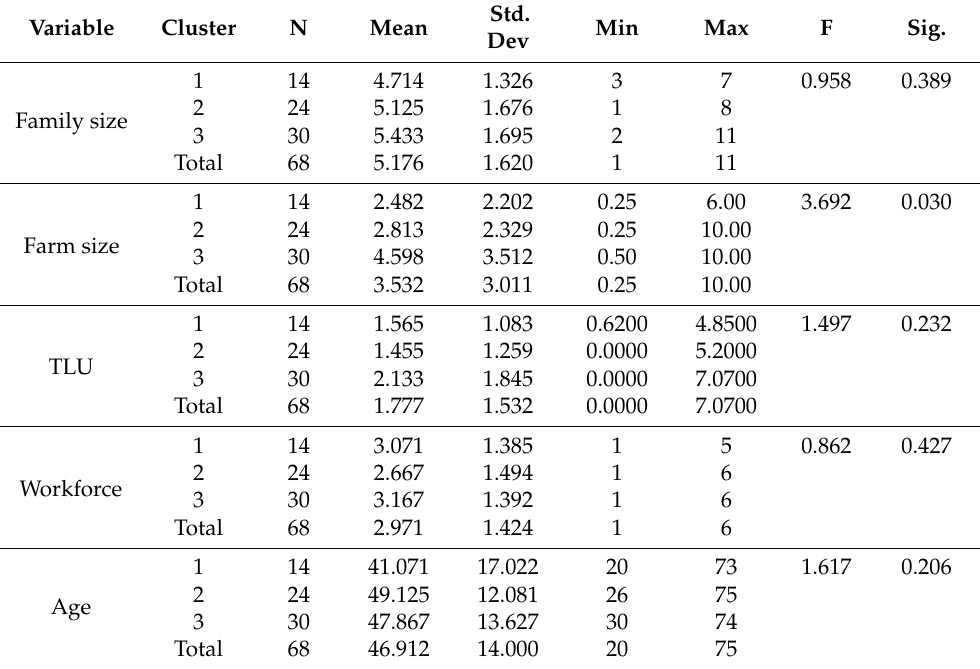
Table 8. Characterization of identified farm types based on p -value of one-way analysis of variance (equality of mean) of socio-economic characteristics.